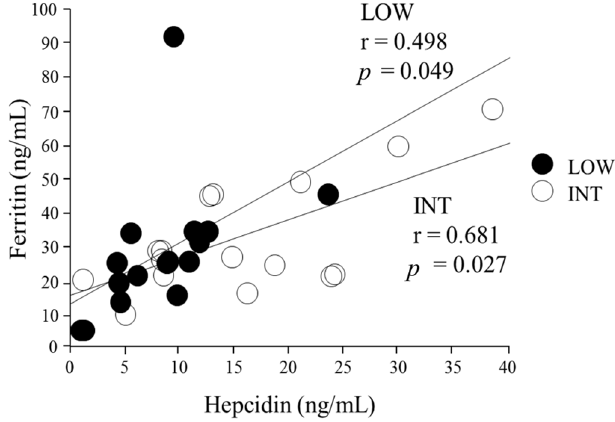
Figure 3. Correlation between serum hepcidin and ferritin levels. Table 3. Comparisons of energy and macronutrient intakes during the three ‐ day training period.